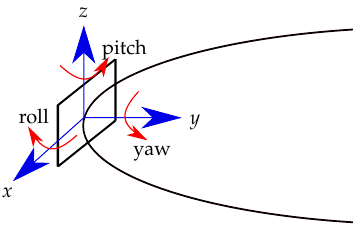
Figure 8. A representative sensor and its reference coordinate system (blue). The sensor is rotated around the three angles of roll, yaw, and